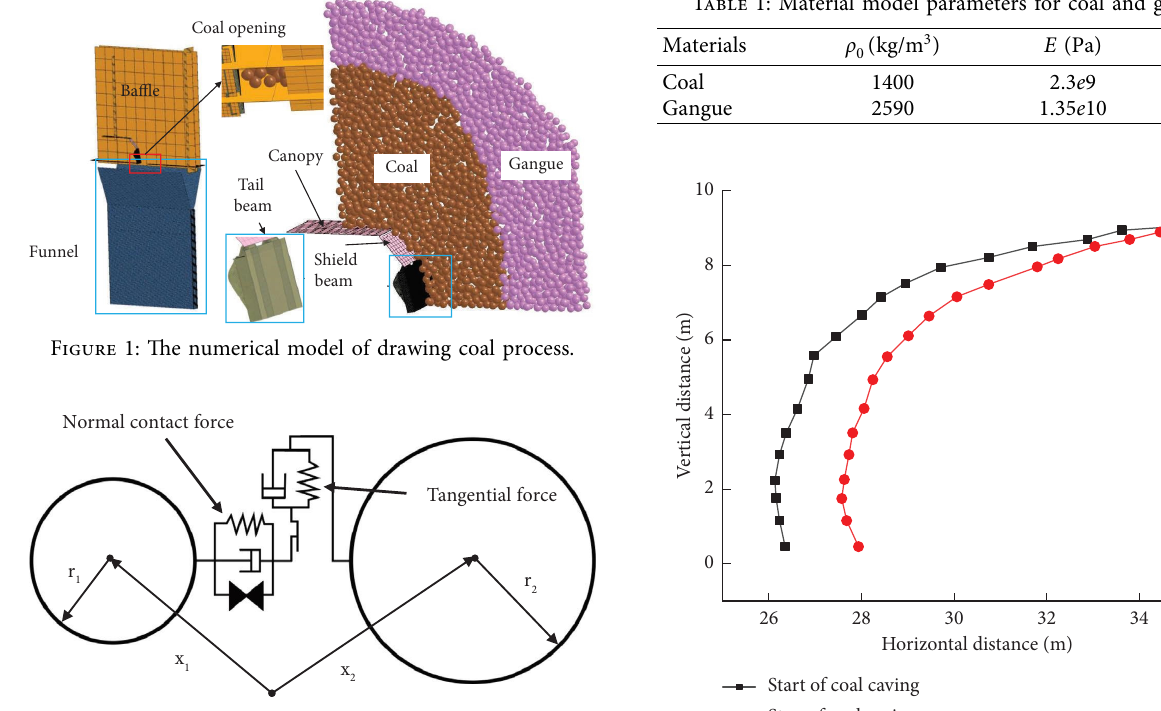
Figure 2: Force between graph particles.